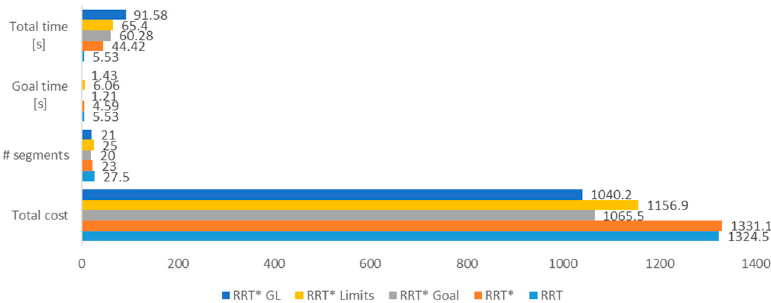
Figure 12. Results of the algorithms for the two obstacles scenario and 600 iterations.